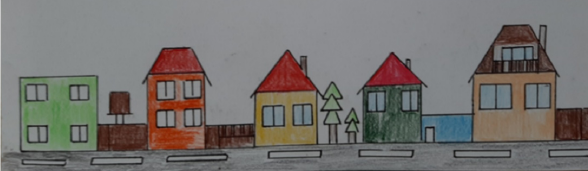
Figure 17. Solution of Task 7 ( top ), and one of the student´s solution ( bottom ). Figure 18. One solution of Task 8. Figure 18. One solution of Task 8. Figure 18. One solution of Task 8.